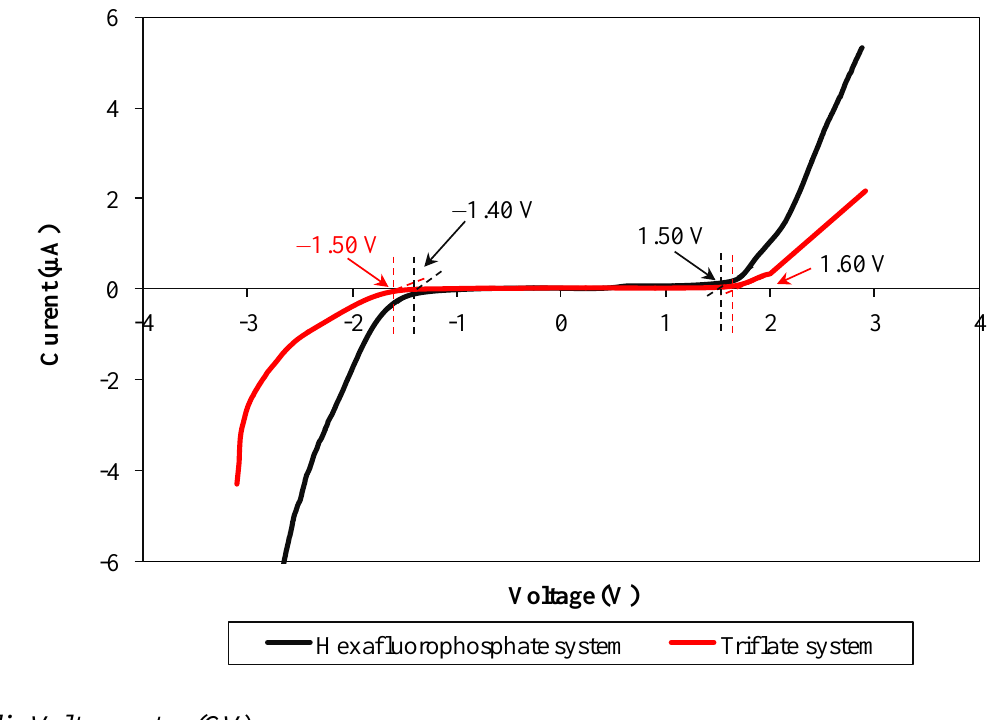
Figure 4. Linear sweep voltammetry (LSV) responses of different ionic liquid-based biopolymer electrolyte